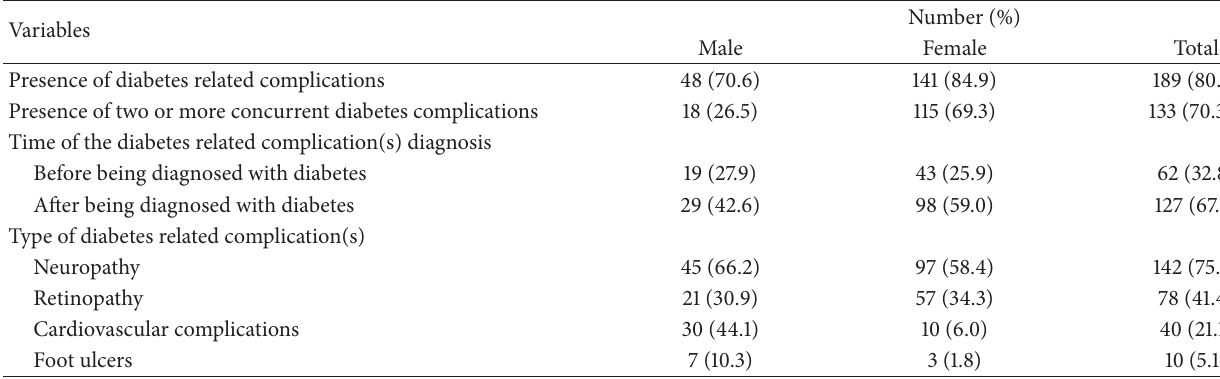
Table 3: Patterns of the type 2 diabetes related complications in the studied patients.